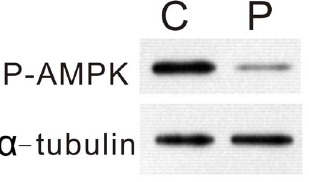
Figure 5. In vivo inhibition of AMPK phosphorylation of prothoracic glands by PTTH. P, larvae injected with saline containing PTTH; C, larvae injected with saline only. Results shown are representative of three independent